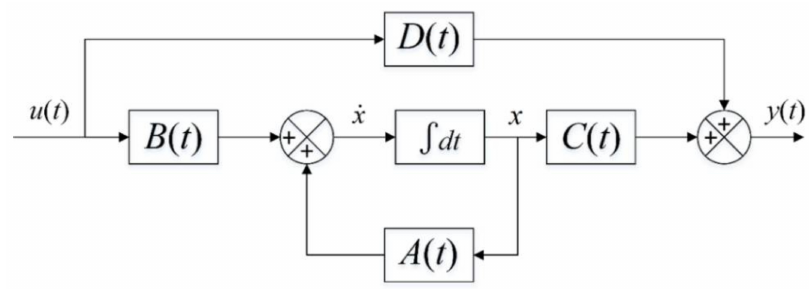
Figure 3. State space system block